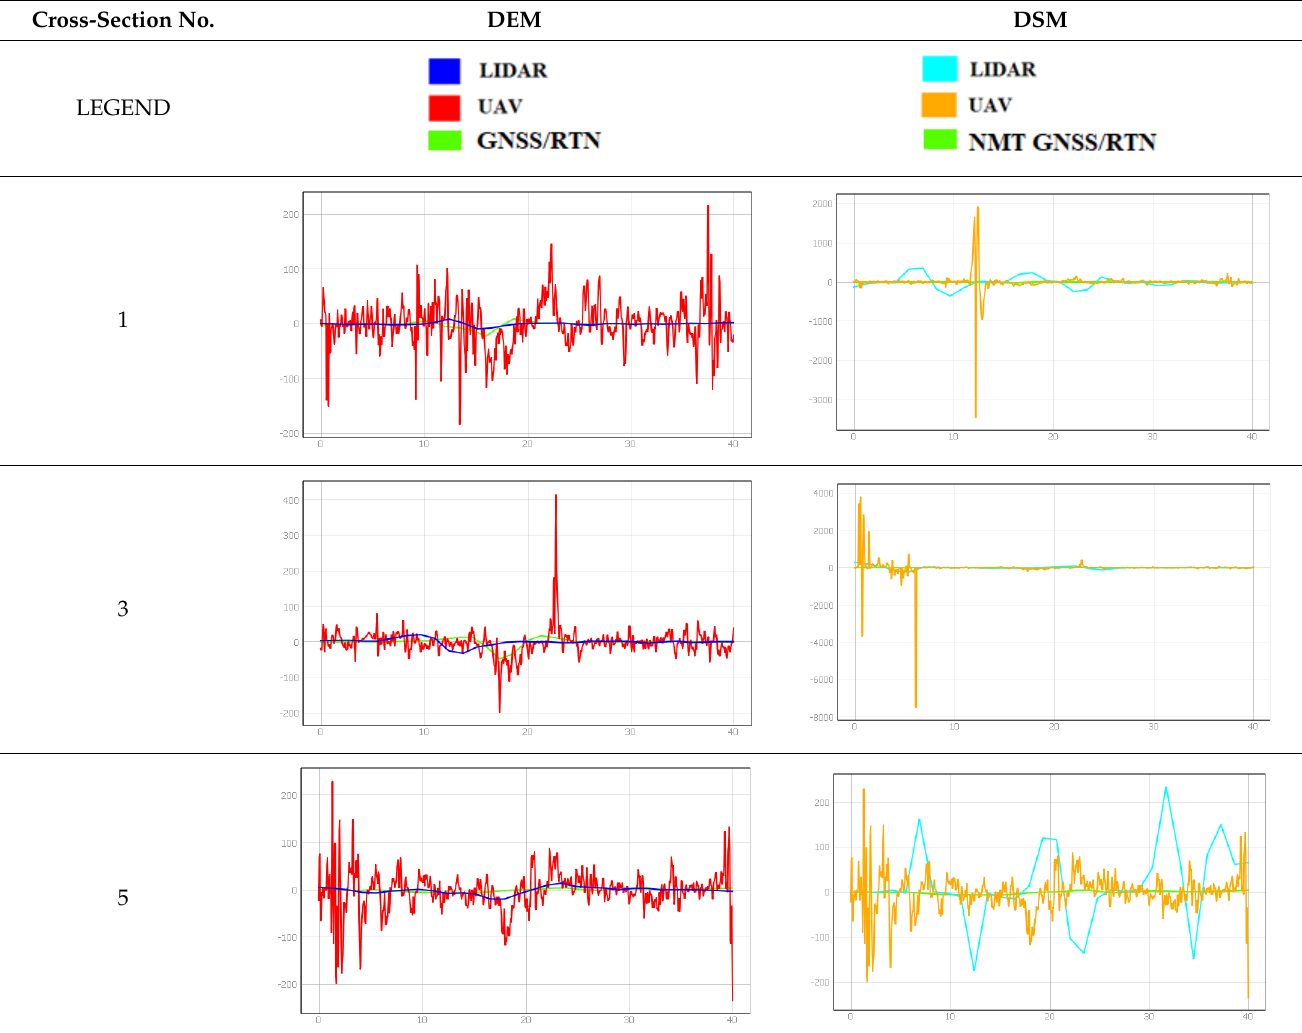
Table 5. Slope of land on cross-sections through watercourse bed on the DEM and DSM in raster form; source: own elaboration.